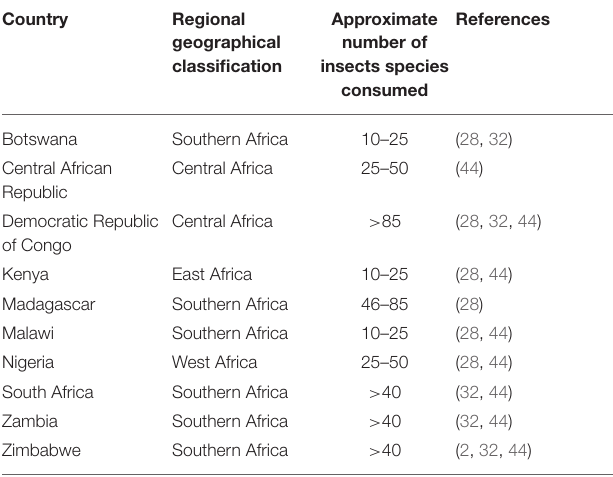
TABLE 1 | Sub-Saharan African countries with high diversity of edible insects consumed as food. Country Regional